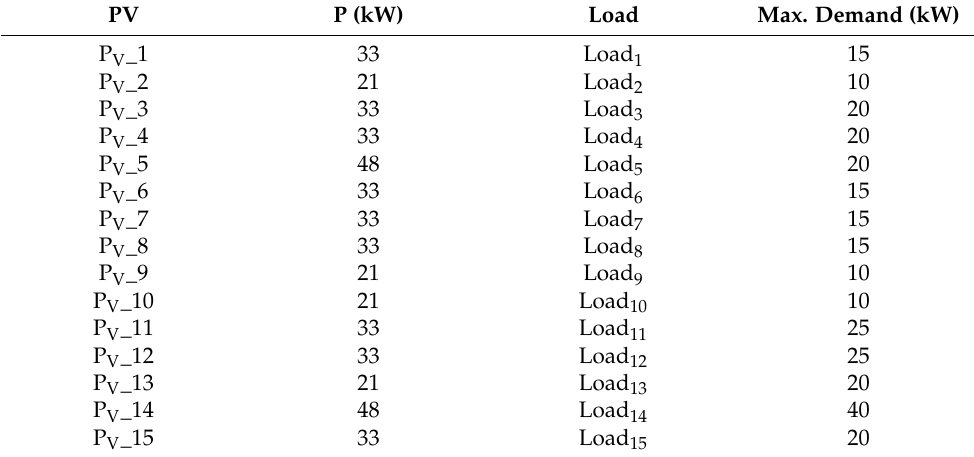
Table 2. Parameters of PV and Load.